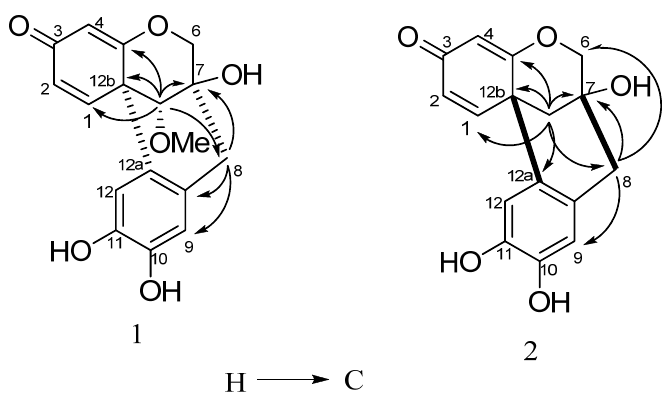
Figure 2. Key HMBC correlations of compound 1 and 2 .